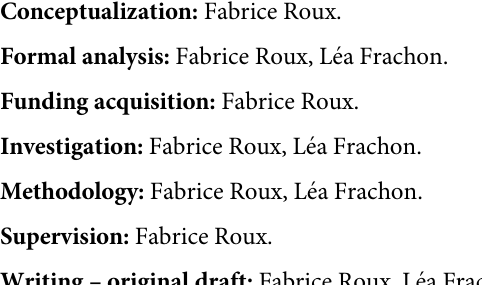
S6 Fig. Comparison of the polygenic architecture underlying natural genetic variation of disease index and total seed production within each micro-habitat. (A) soil A in absence of Poa annua . (B) soil A in presence Poa annua . (C) soil B in absence of Poa annua . (D) soil C in absence of Poa annua . (E) soil C in presence Poa annua . Manhattan plot of the Lindley process (local score method with a tuning parameter ξ = 2). The x-axis indicates the physical position of the 981,617 SNPs along the five chromosomes. The dashed lines indicate the minimum and maximum of the five chromosome-wide significance